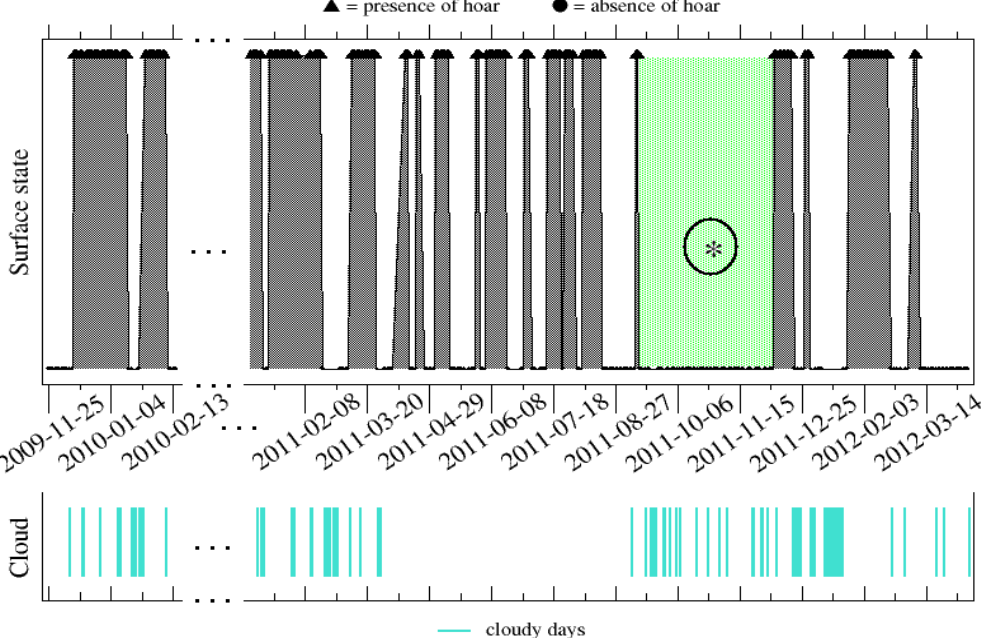
Fig. 6. Evolution of the surface state at Dome C (dark and dotted areas show periods with presence of hoar), from 23 November 2009 to 16 February 2010, and from 3 January 2011 to 11 April 2012. Green and dotted area ( ∗ ) is a remarkably long period without hoar crystals and cyan lines show cloudy